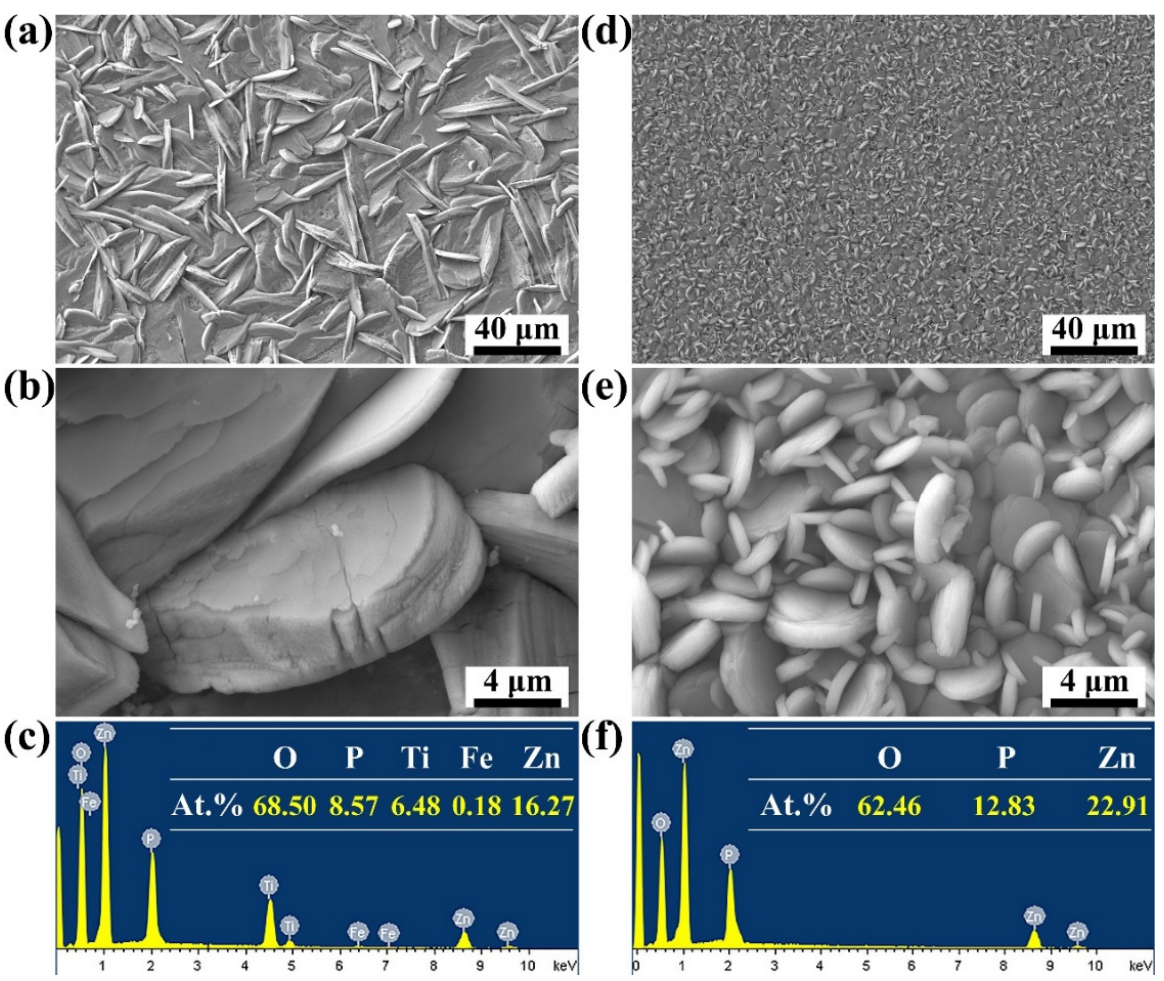
Figure 2. The FE ‐ SEM morphologies and elemental composition of ZnP coating on TA ( a – c ) and Figure 2. The FE-SEM morphologies and elemental composition of ZnP coating on TA ( a – c ) and ZA ( d – f ). ZA ( d – f